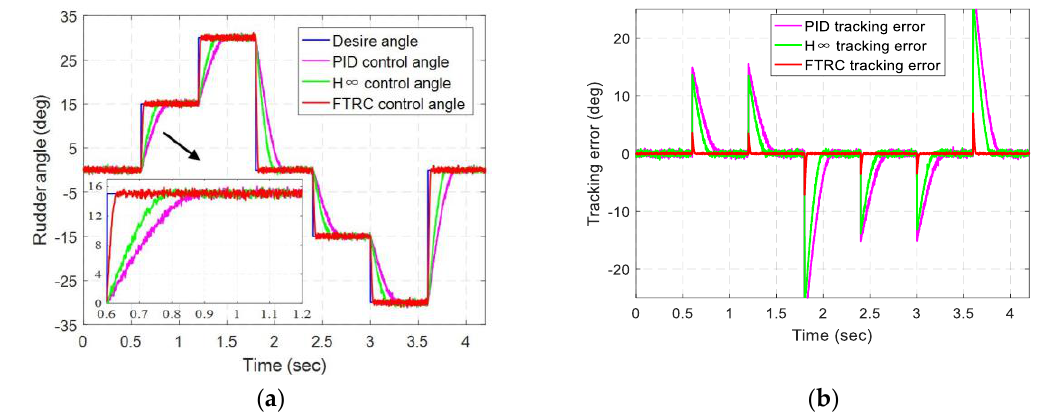
Figure 11. Actual response and error of different algorithm under input step signal: ( a ) system response; ( b ) system response error.